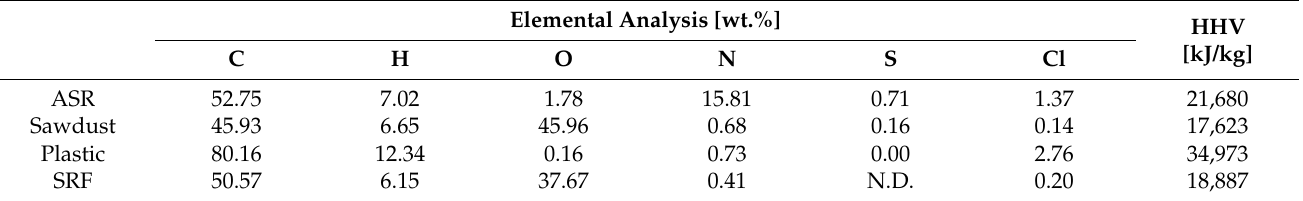
Table 7. Results of Elemental Analysis for ASR and Other Wastes.